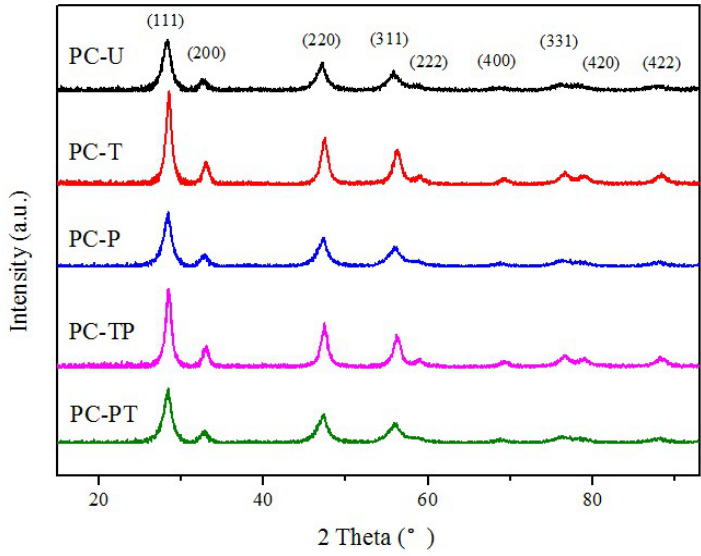
Figure 4. XRD pattern of different Pt/CeO 2 samples.